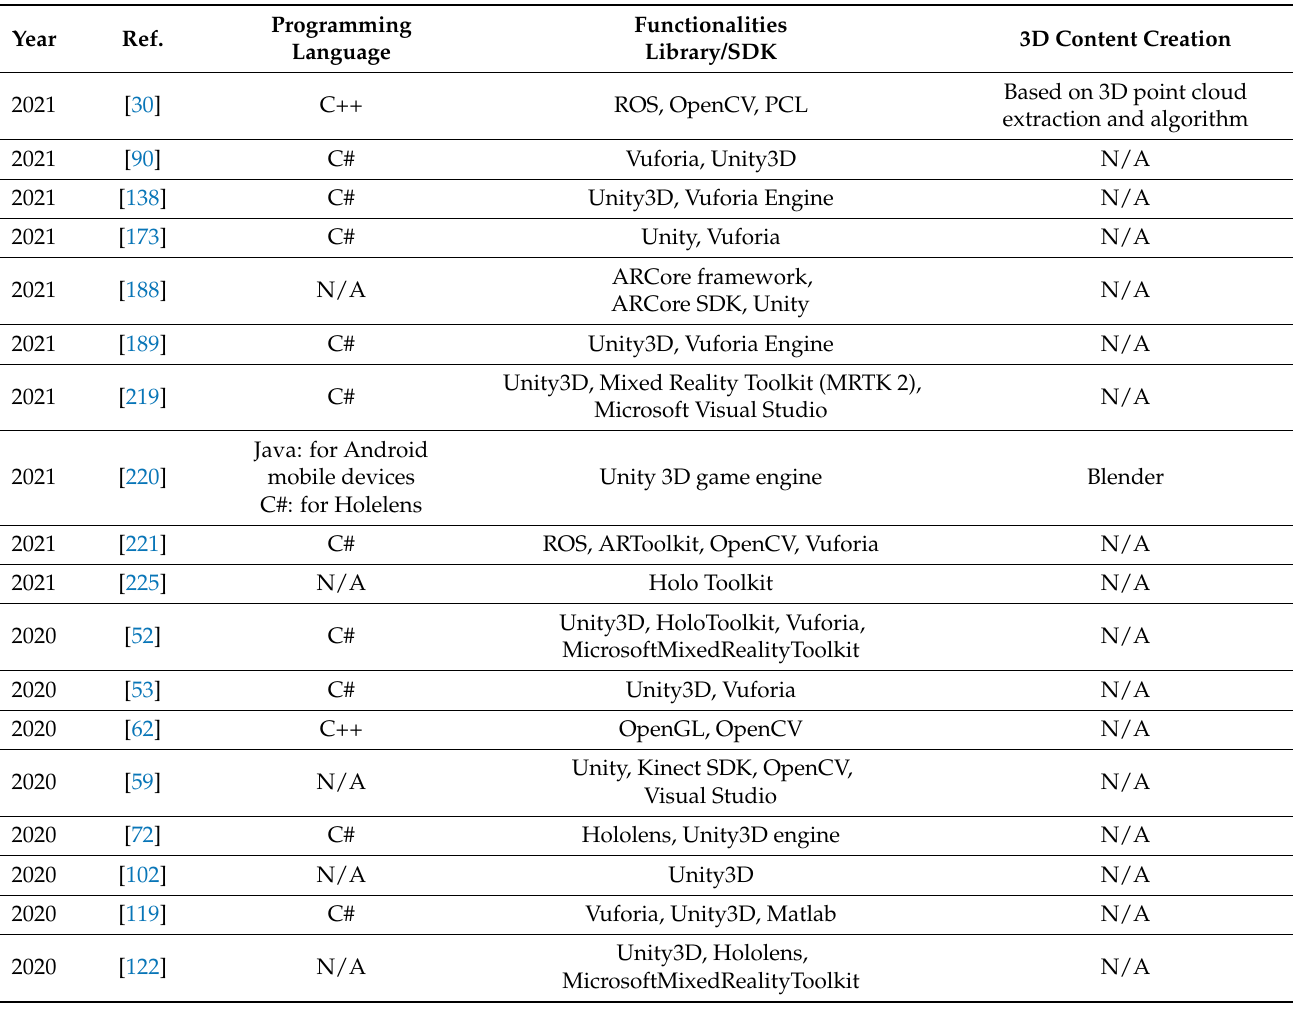
Table 16. Software development elements mentioned in selected articles